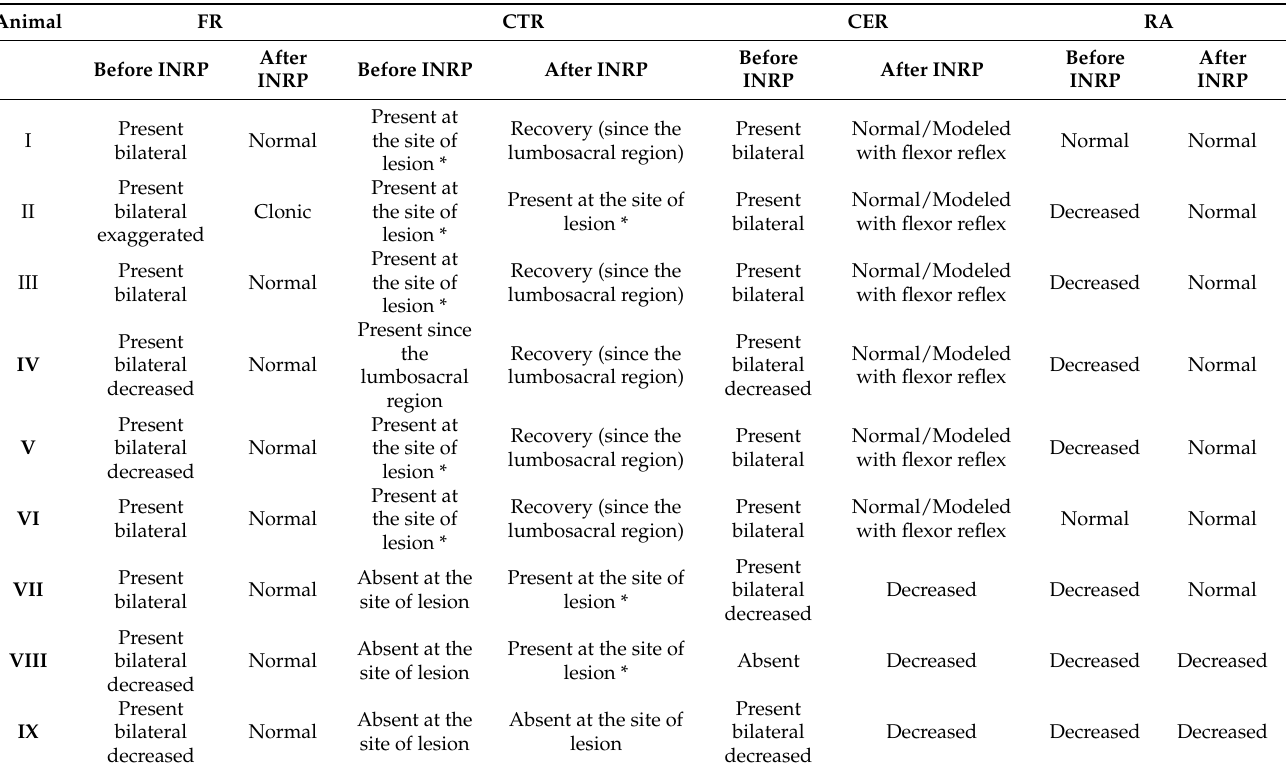
Table 2. Classification of peripheral spinal reflexes and muscle tone of the rectus abdominis, before and after the application of INRP (medical